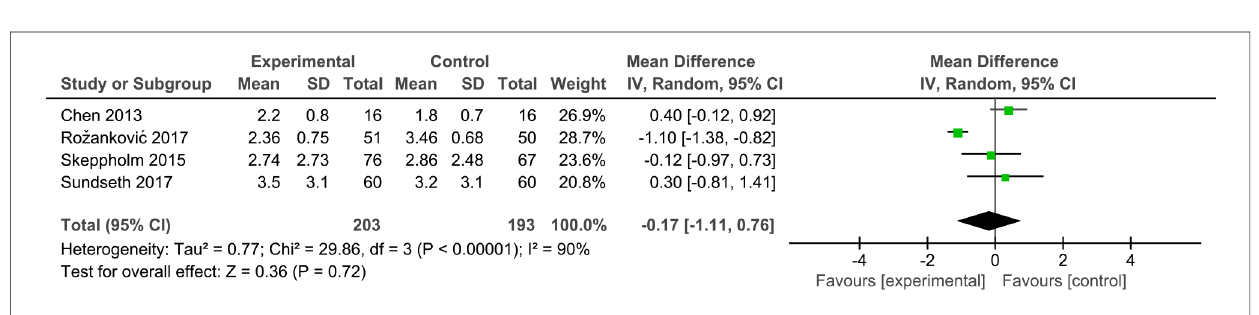
FIGURE 4 Comparison of VAS NECK score between the discover cervical disc arthroplasty (DCDA, “ experimental ” ) group and the anterior cervical discectomy and fusion (ACDF, “ control ” ) group.